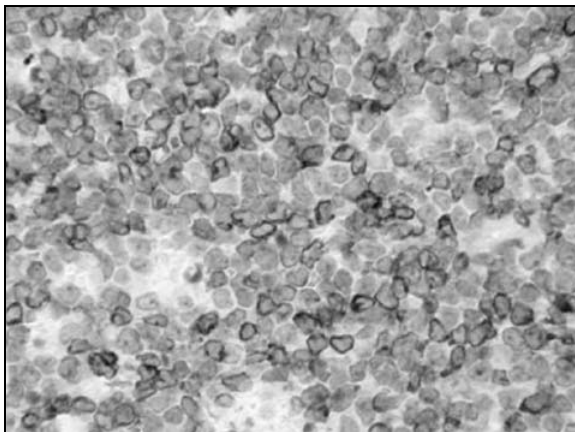
Figura 3 (caso 1) – Imunorreatividade nas membranas celulares de células neoplásicas para CD79a (400x)